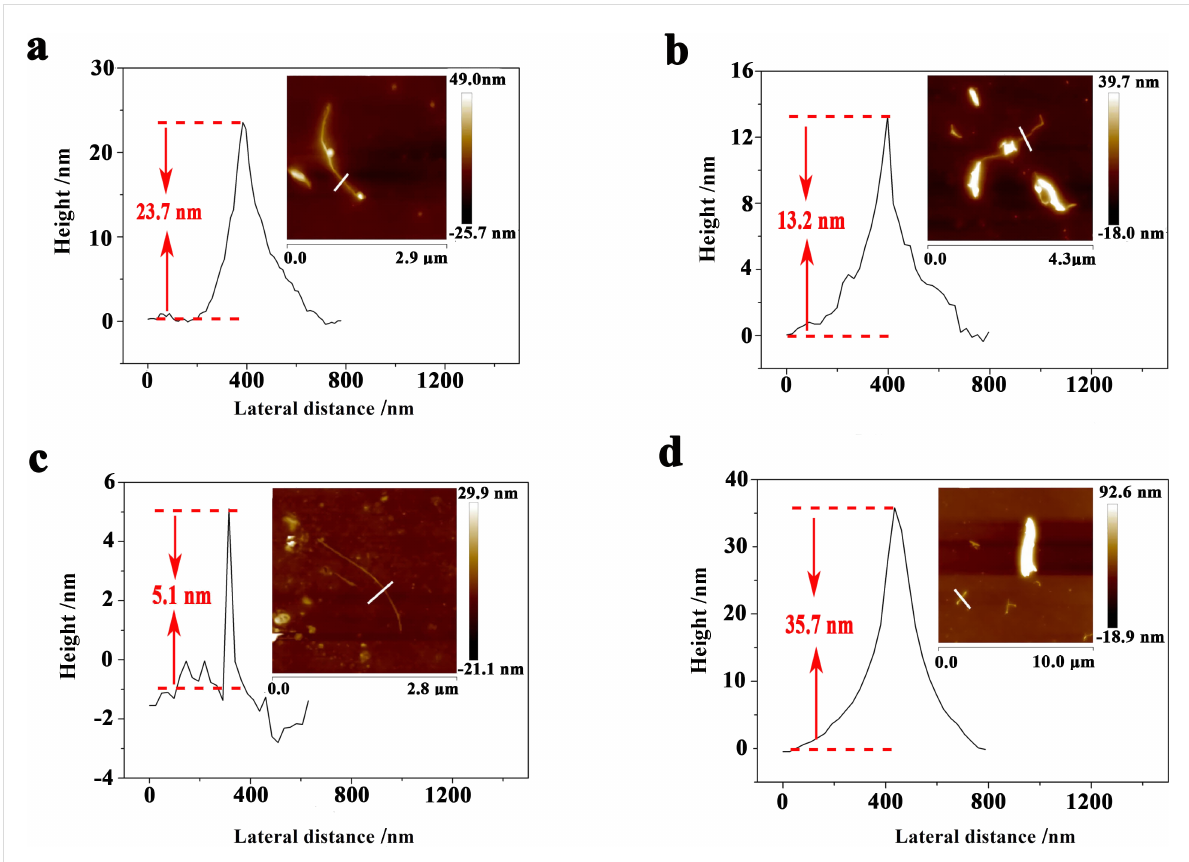
Figure 8: Sizes of exfoliated KP 15 nanowires. (a) Cross section of the KP 15 nanowire marked in the upper right corner inset image. (b) Cross section of the KP 15 nanowire marked in the upper right corner inset image. (c) Cross section of the KP 15 nanowire marked in the upper right corner inset image. (d) Cross section of the KP 15 nanowire marked in the upper right corner inset image.